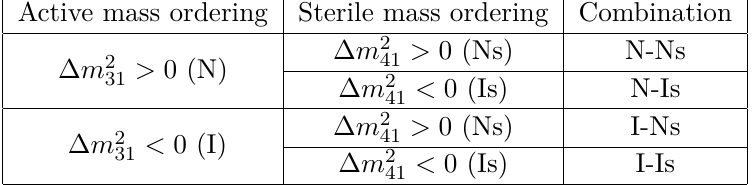
Table 1 . All four possible combinations of active and sterile mass